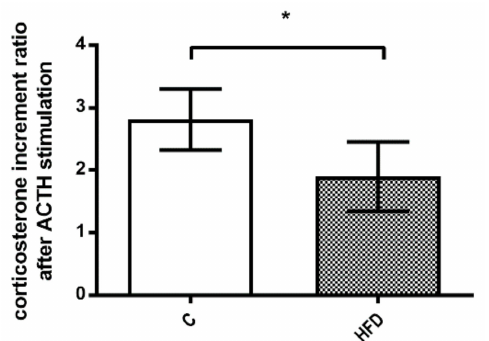
Figure 7. The corticosterone response to ACTH injection after LPS-induced septic shock. HFD group had a significant decrease in corticosterone increment ratio even after ACTH stimulation in septic shock status. (* p <